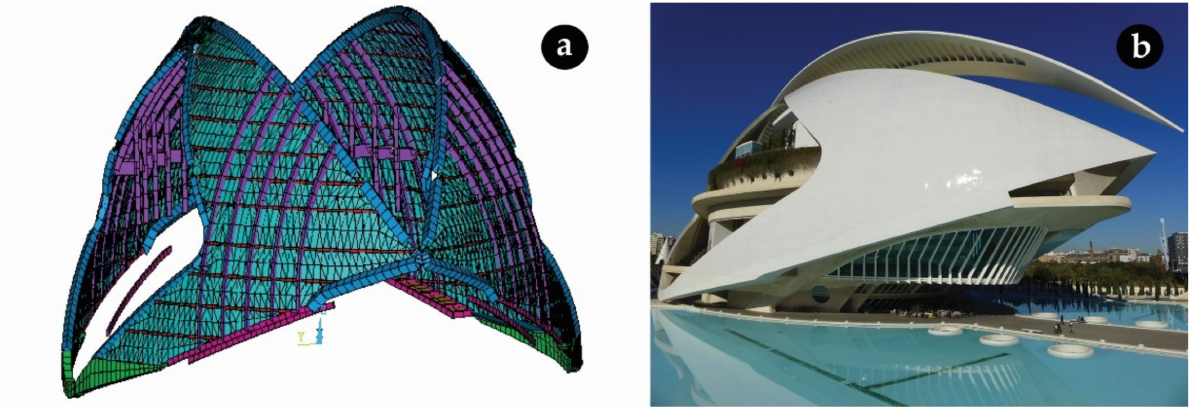
Figure 4. Palau de les Arts Reina Sofia, Valencia (2005): ( a ) finite element model of the metal shields; ( b ) the building upon completion. Reprinted with permission from ref. [28]. Copyright 2008 Asociaci ó n Cient í fico-Tecnica del Hormig ó n Estructural